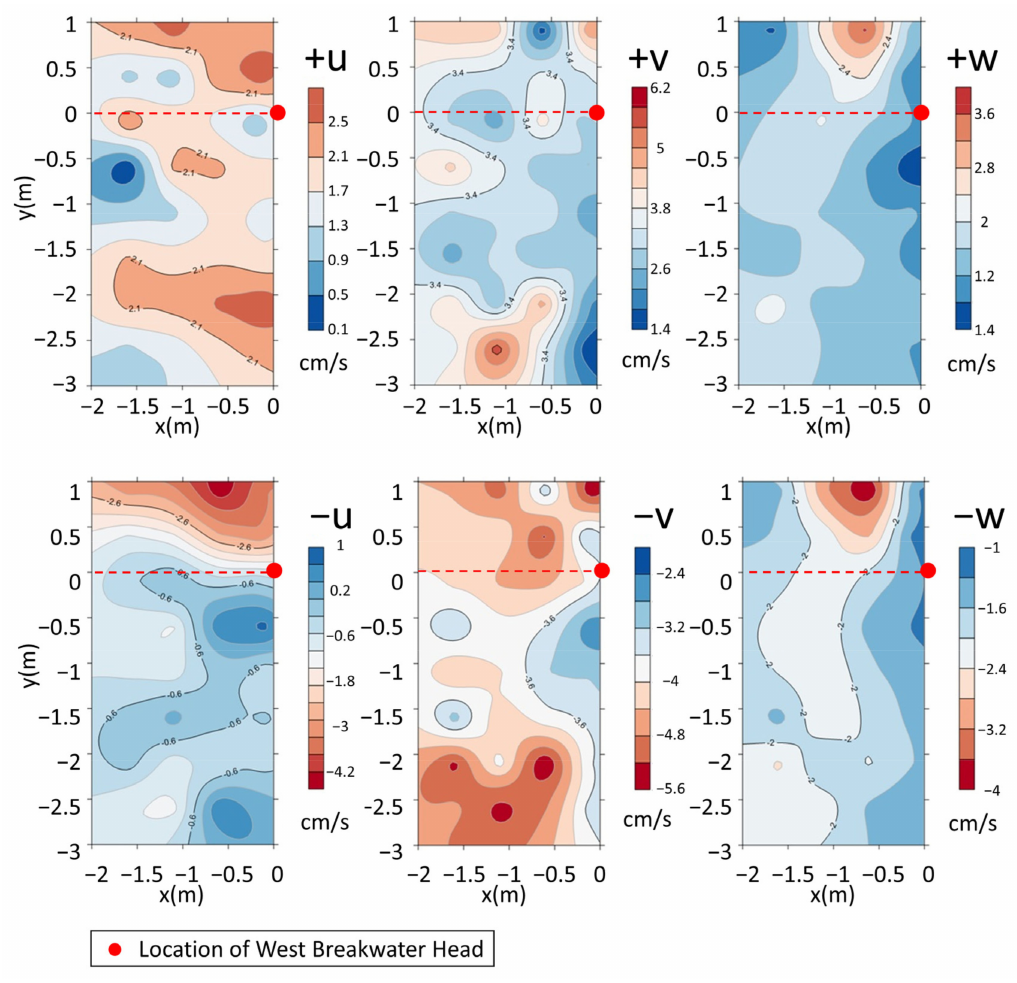
Figure 20. Max u, v, w at west side of the West Breakwater (z = − 15 m).